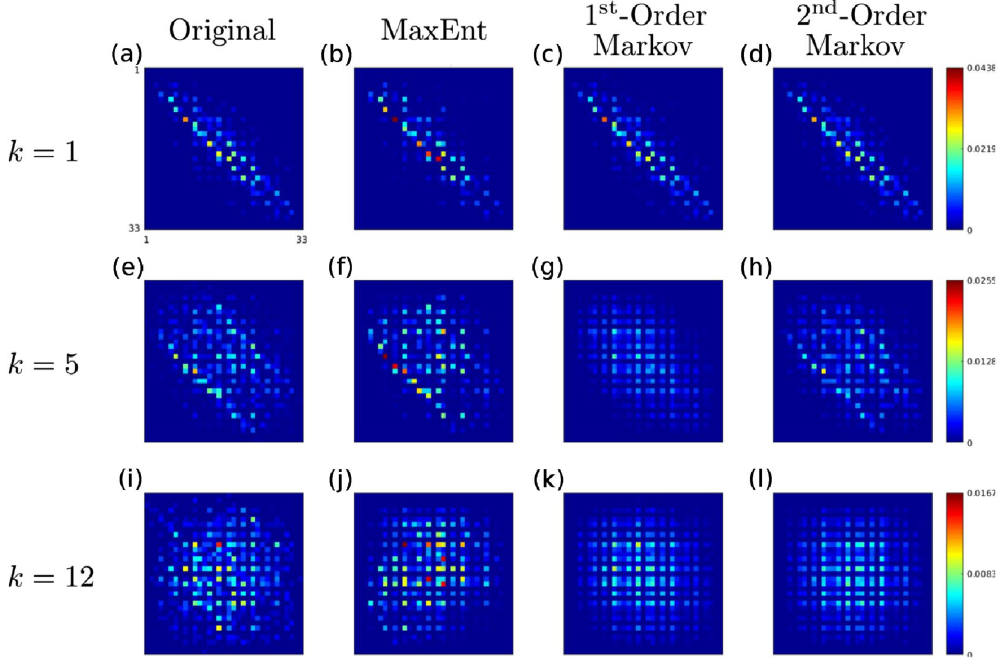
Figure 3. Matrices of pair frequencies. Color-maps representing matrices obtained by counting pair frequencies (see eq. (3)). ( a – d ) Pair frequences at distance k = 1 for the followig models: the original sequence by J.S. Bach (see Section S3 of the SI), our Maximum Entropy model with K max = 10, a first-order and a second- order Markov model. ( e–h ) the same for k = 5. ( i–l ) the same for k =